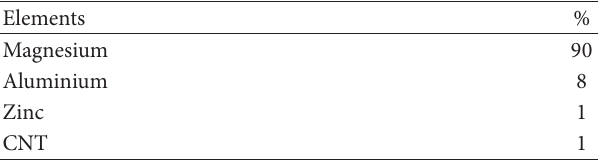
Table 1: Percentage of elements present in magnesium composite.